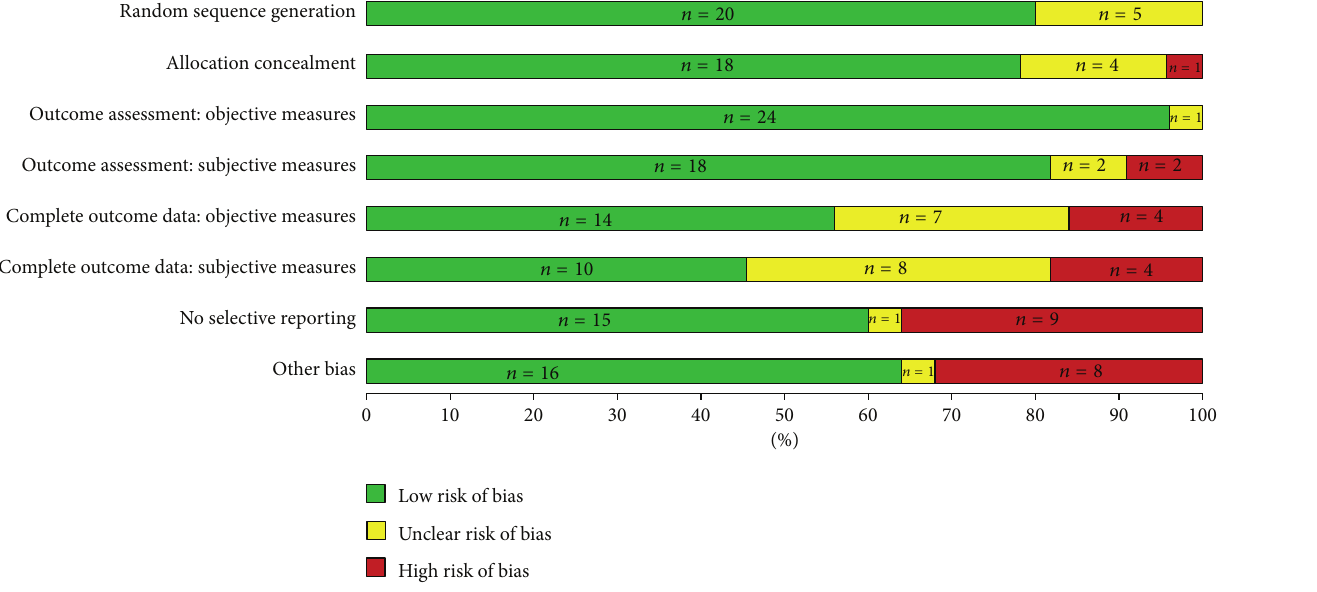
Figure 5: Risk of bias horizontal graph of CNS studies ( 𝑛 = 25